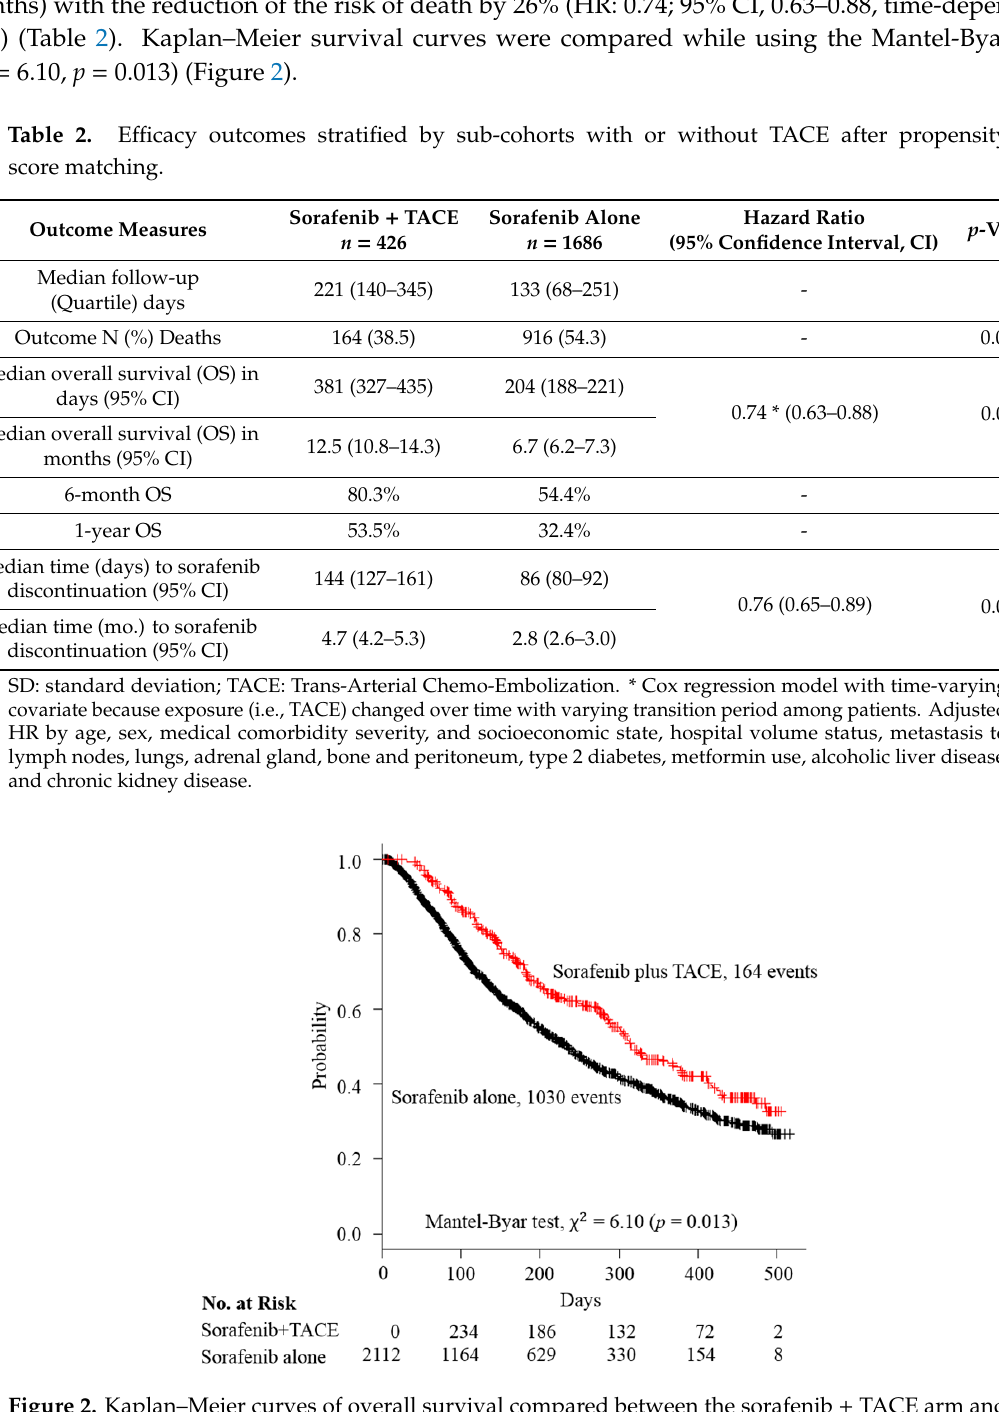
Figure 2. Kaplan–Meier curves of overall survival compared between the sorafenib + TACE arm and sorafenib alone arm. Abbreviation: TACE, transcatheter arterial embolization.